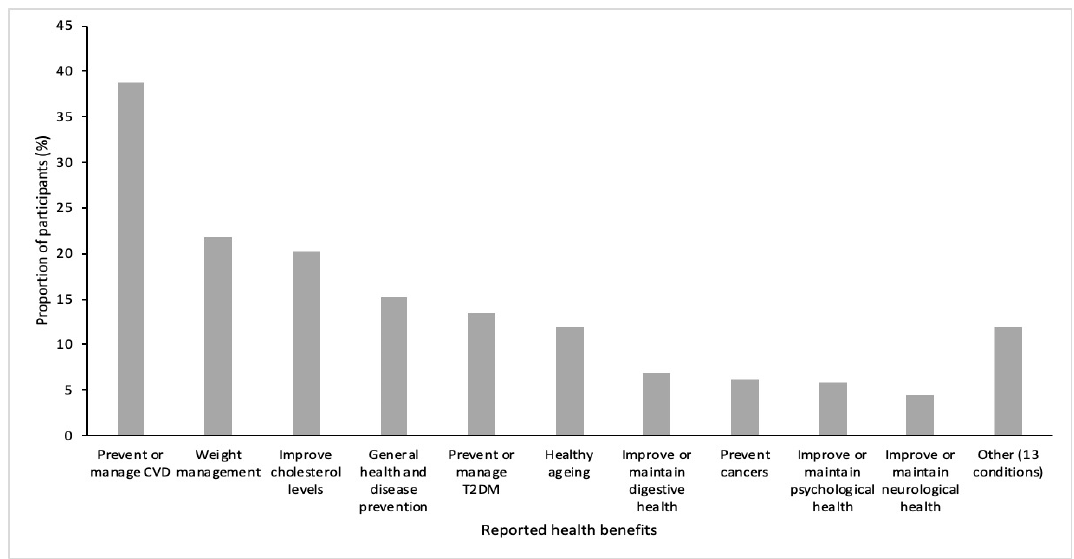
Figure 1. Perceived health benefits of following a Mediterranean diet, as reported by n = 445 survey participants. Abbreviations: CVD, Cardiovascular disease; T2DM, Type 2 diabetes mellitus.